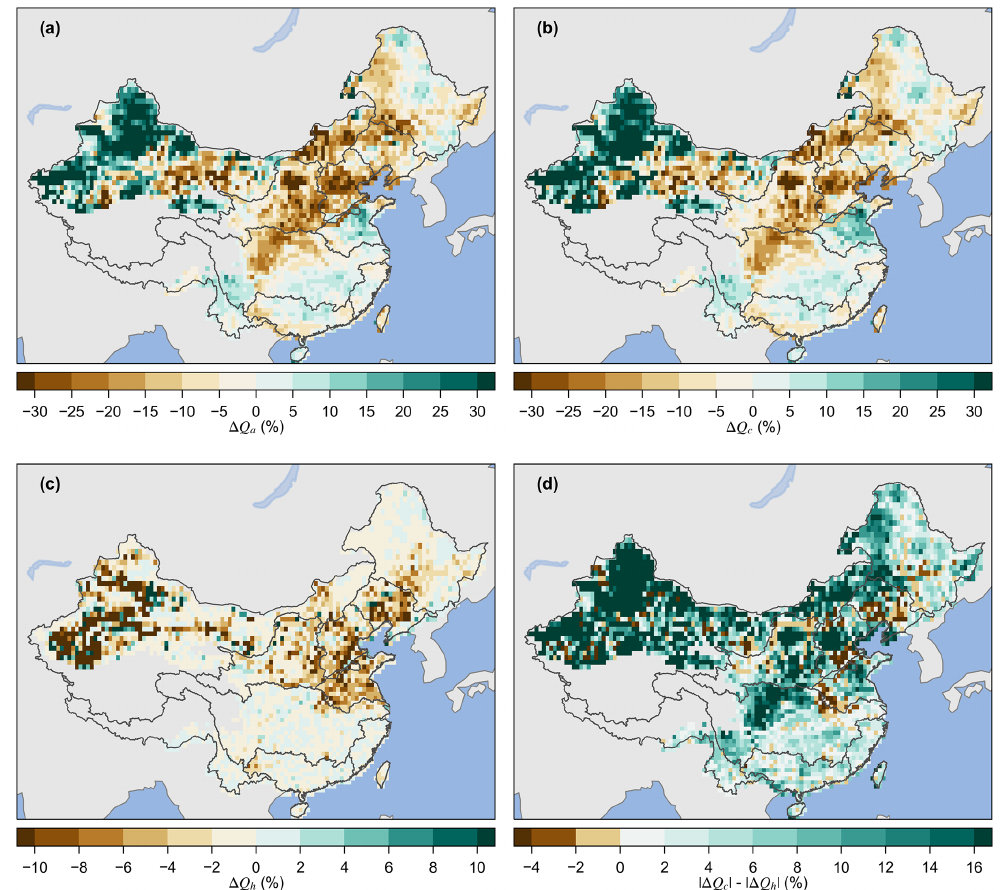
Figure 5. Relative changes (%) in long-term MAF over China between the two sub-periods (1971–1990 and 1991–2010). (a) Total MAF changes ( (cid:49)Q a ) . (b) MAF changes induced by climate change ( (cid:49)Q c ) . (c) MAF changes induced by DHI changes ( (cid:49)Q h ) ; (d) the difference between the magnitudes of (cid:49)Q c and (cid:49)Q h